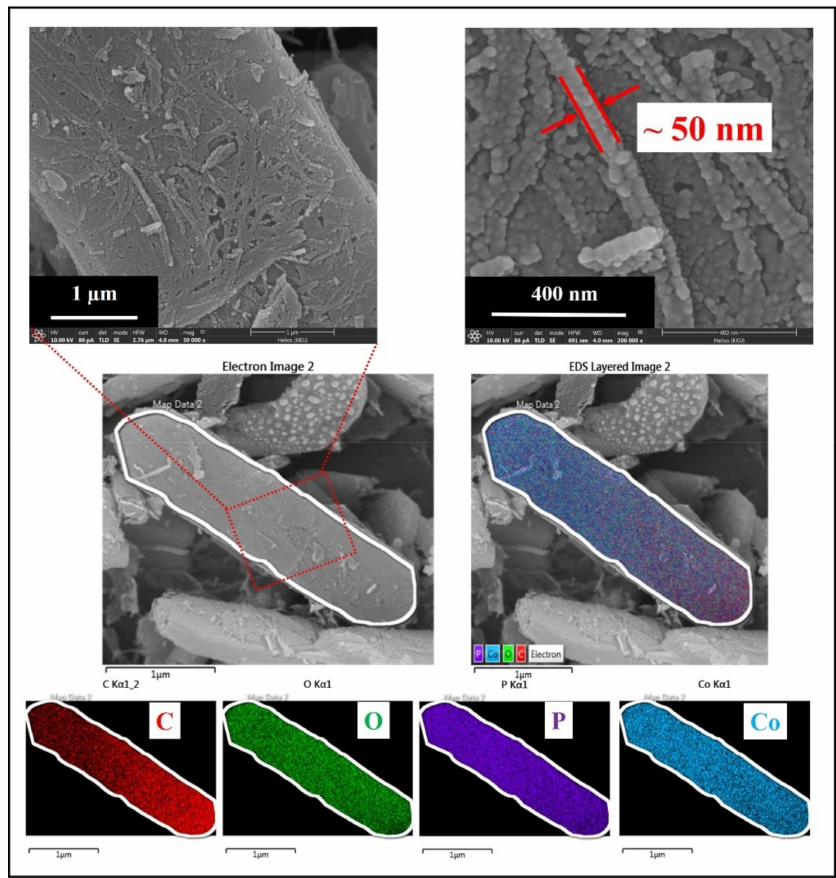
Figure 5. FE–SEM images and selected area elemental mappings of Co 2 P 2 O 7